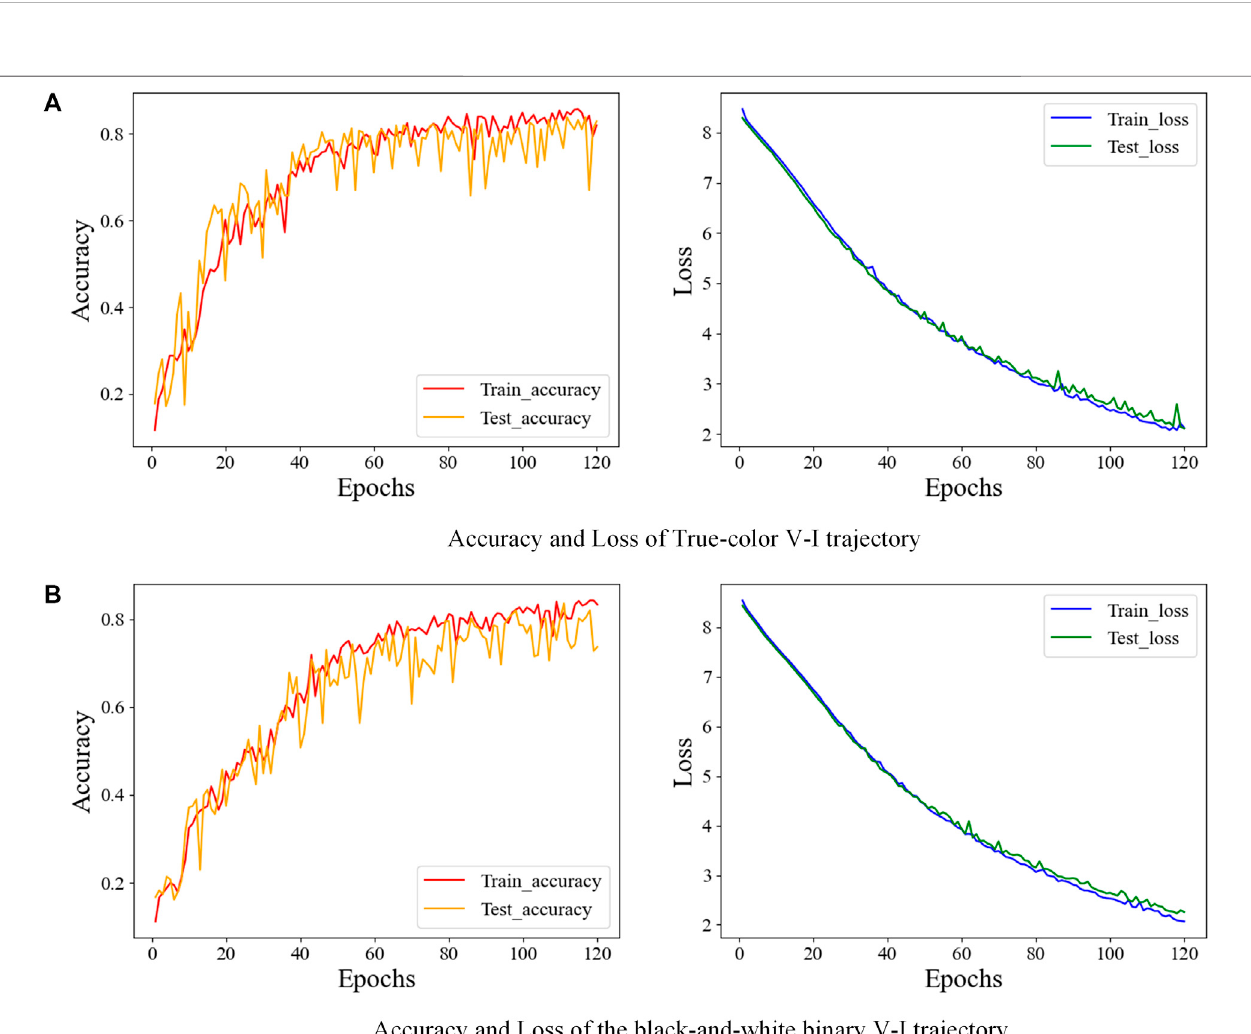
FIGURE 5 | Accuracy and loss change